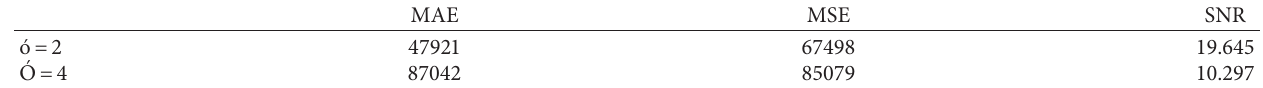
Table 1: Image quality evaluation table under different noises.